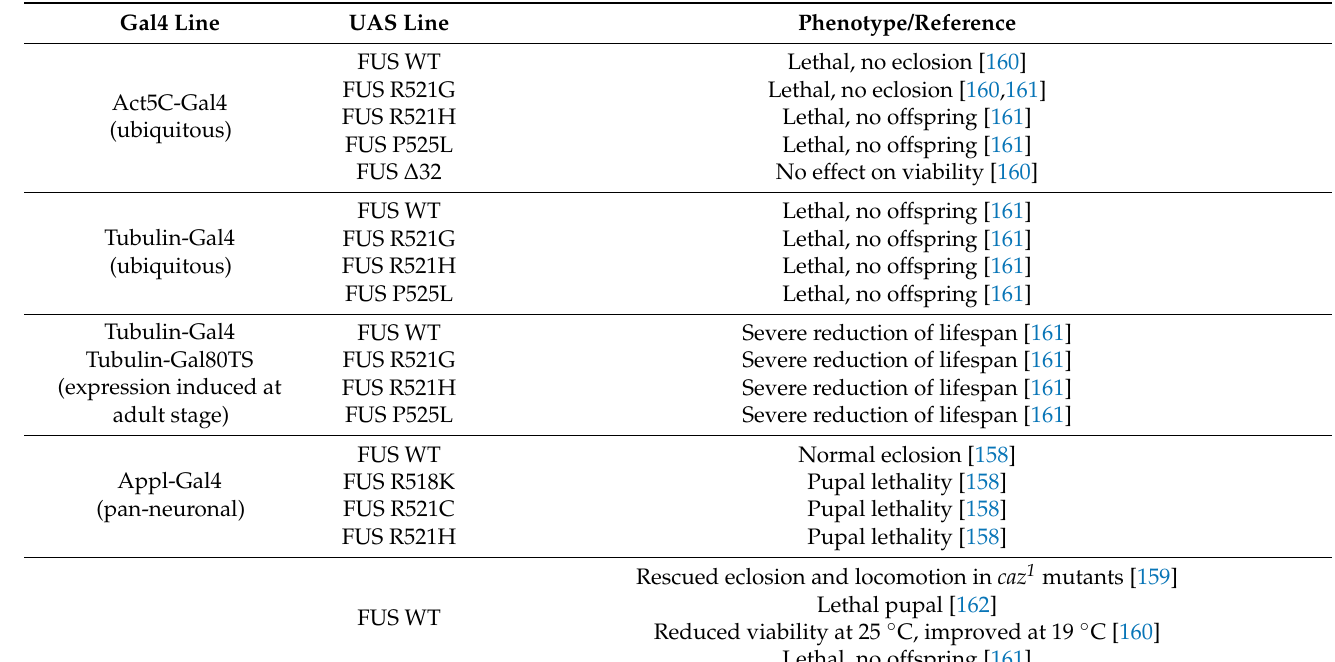
Table 3. Gain-of-function phenotypes induced by FUS. CNS, central nervous